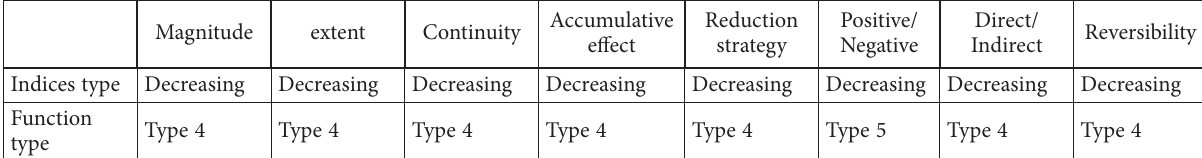
Table 1. Criteria type and